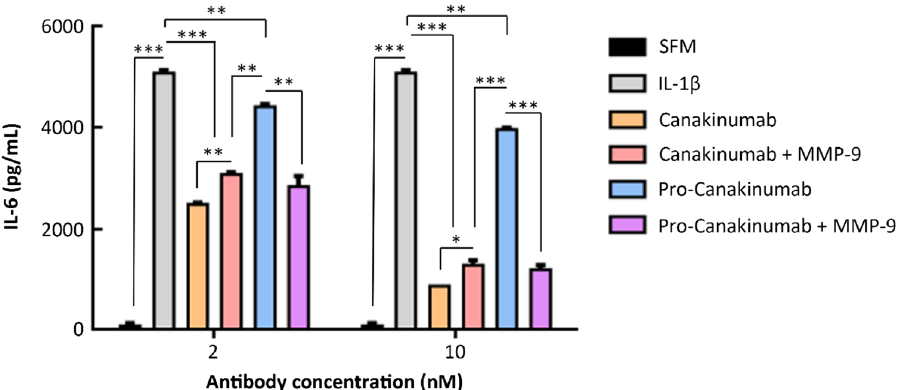
Figure 5. Effect of pro-Canakinumab on IL-1β-induced IL-6 expression. Human lung carcinoma cell line A549 (1.2 × 10 5 ) was treated with IL-1β (5 ng/mL, gray), and incubated with serum free medium (SFM) (black), Canakinumab (orange), pro-Canakinumab (blue), MMP-9 pre-incubated Canakinumab (pink) or MMP-9 pre-incubated pro-Canakinumab (purple) for 24 h. The supernatant was collected and the expression level of IL-6 was detected by human IL-6 DuoSet ELISA kit (R&D Systems, Minneapolis, MN, USA) according to the manufacturer’s protocol. All data are the mean ± SD of triplicate independent experiments (n = 3). Statistical significance was calculated by t test with * P < 0.05; ** P < 0.01; *** P < 0.001 when compared between each indicated